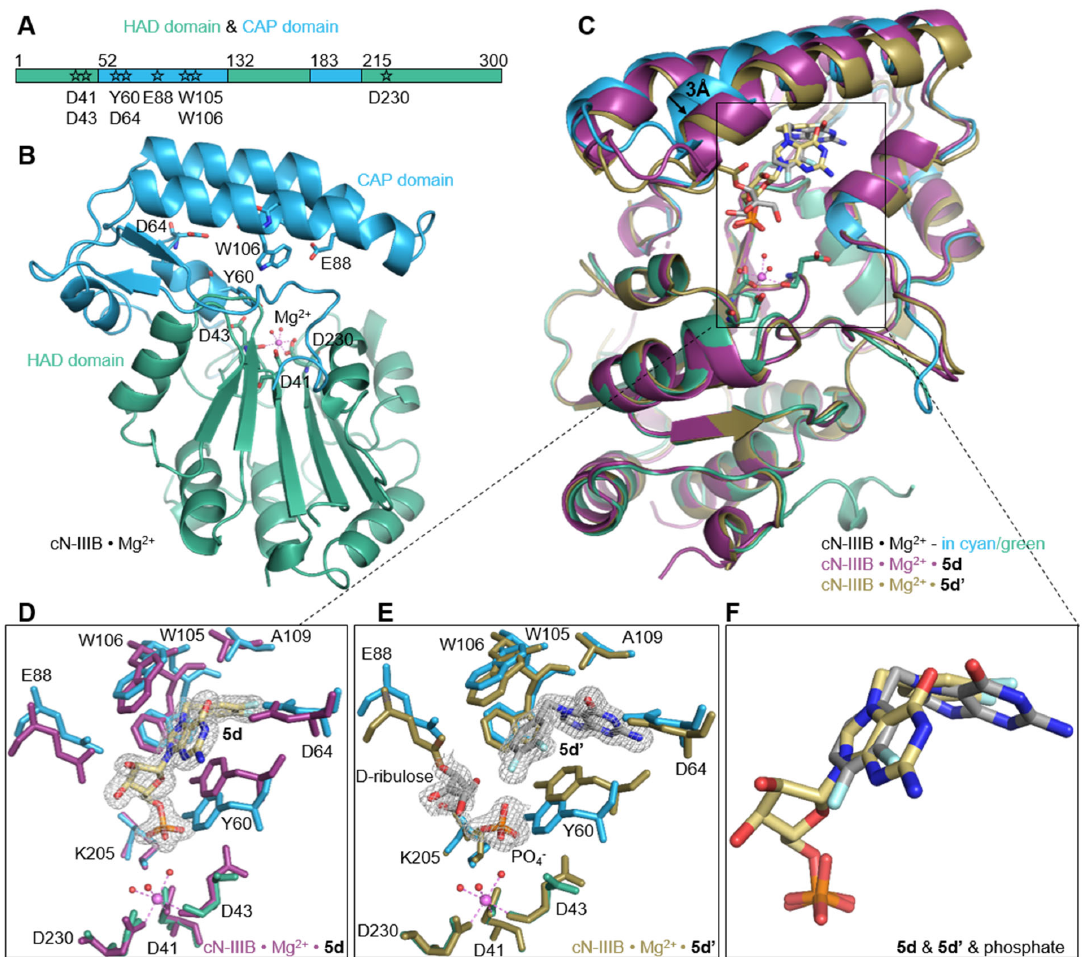
Figure 5. Structural rearrangements of the human cN ‐ IIIB enzyme upon ligand binding. ( A , B ) Sche ‐ matic representation of the domain structure of the enzyme and the cartoon representation of the crys ‐ tal structure of cN ‐ IIIB • Mg 2+ complex. CAP and HAD domain are colored in blue and green, respec ‐ tively. The residues responsible for cap recognition are located in the CAP domain and the aspartic acids, which coordinate magnesium ion (magenta sphere) and form the catalytic center, are located in the HAD domain. The residues are shown as sticks in the structure and are marked as stars on the domain scheme. ( C ) Structural alignments showing the movement of the CAP domain under